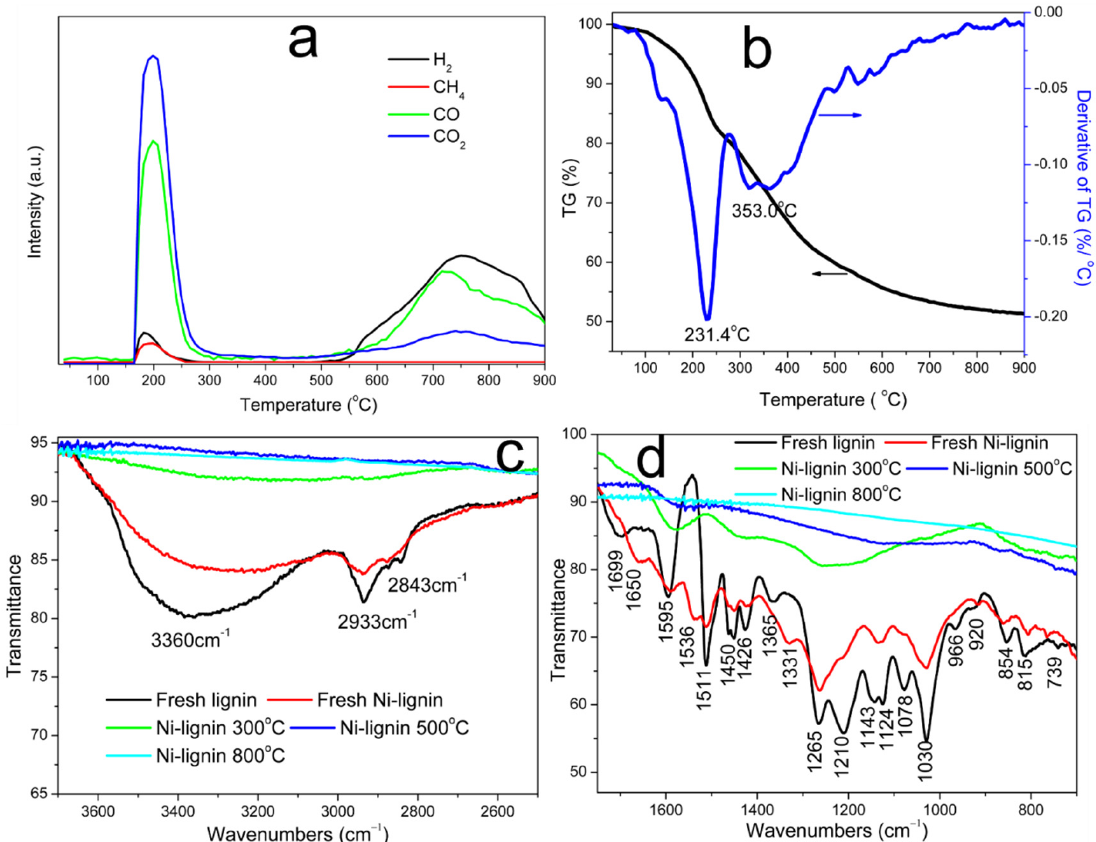
Figure 1. Gas evolution profiles of temperature-programmed carbonization ( a ), TG/DTG curves ( b ) of the Ni-lignin sample under argon atmosphere, and FTIR spectra ( c , d ) of the kraft lignin and the Ni-lignin composite thermally treated at different temperatures: 300 °C, 500 °C, and 800 °C, respectively.